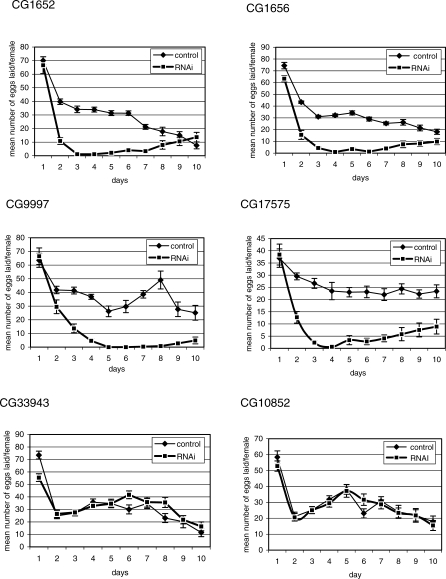
Mean Number (Mean ± SE) of Eggs Laid by the Mates of Knockdown Males (RNAi) or Control Males from Day 1 to Day 10Egg laying by the mates of CG1652, CG1656, CG9997, or CG17575 knockdown males (RNAi) was not significantly different from their controls (p > 0.2) at 24 h ASM but from day 2 onwards, mates of CG1652, CG1656, CG17575, or CG9997 knockdown males laid significantly fewer eggs compared to their controls (p < 0.0001; n = 22–27). On the contrary, mates of CG33943 knockdown males laid significantly fewer eggs only at 24 h ASM (p < 0.0003; n = 30 for control and 27 for knockdown) compared to their controls; from day 2 onwards their levels were similar to the controls (overall p > 0.6). The other Acps did not differ from controls. One example is shown here (CG10852 panel; overall p > 0.8).